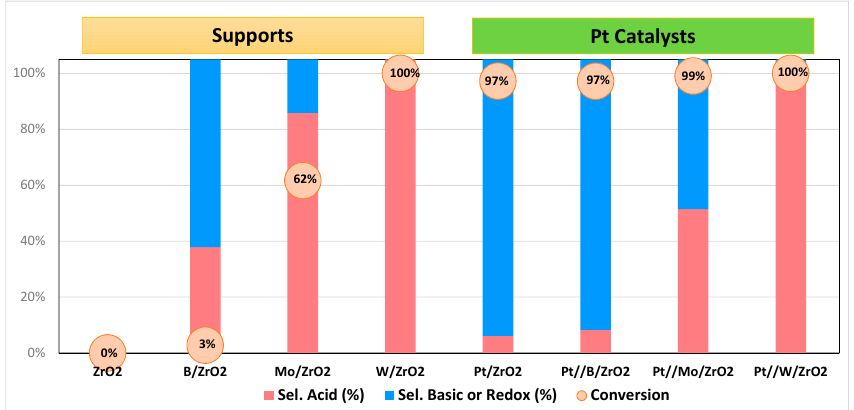
Figure 4. Propan-2-ol conversion and products distribution obtained in the gas-phase propan-2-ol transformation test reaction at 200 °C (time on stream, 2 h). Sel. Acid: selectivity to products formed on acid sites (propene and diisopropyl ether); Sel. Basic or Redox: selectivity to products formed on basic or redox sites (acetone and diacetone alcohol).